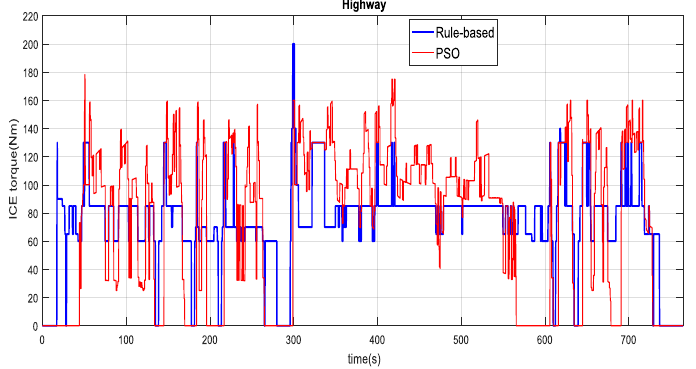
Figure 15. Comparison of engine torque in the highway driving cycle.